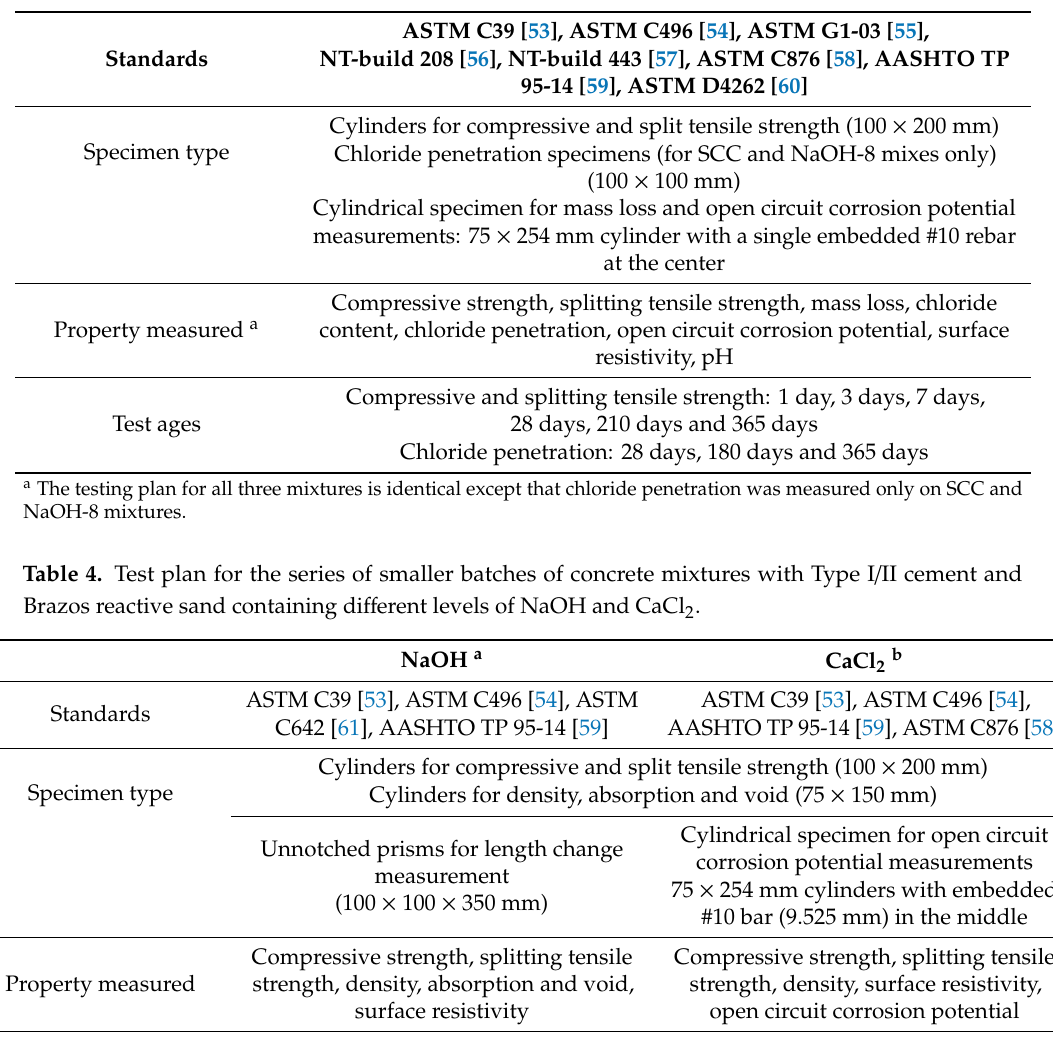
Table 3. Test plan for the series of larger batches of concrete mixtures with Type I / II cement and Brazos reactive sand: SCC, NaOH-8 and CaCl 2 -4.